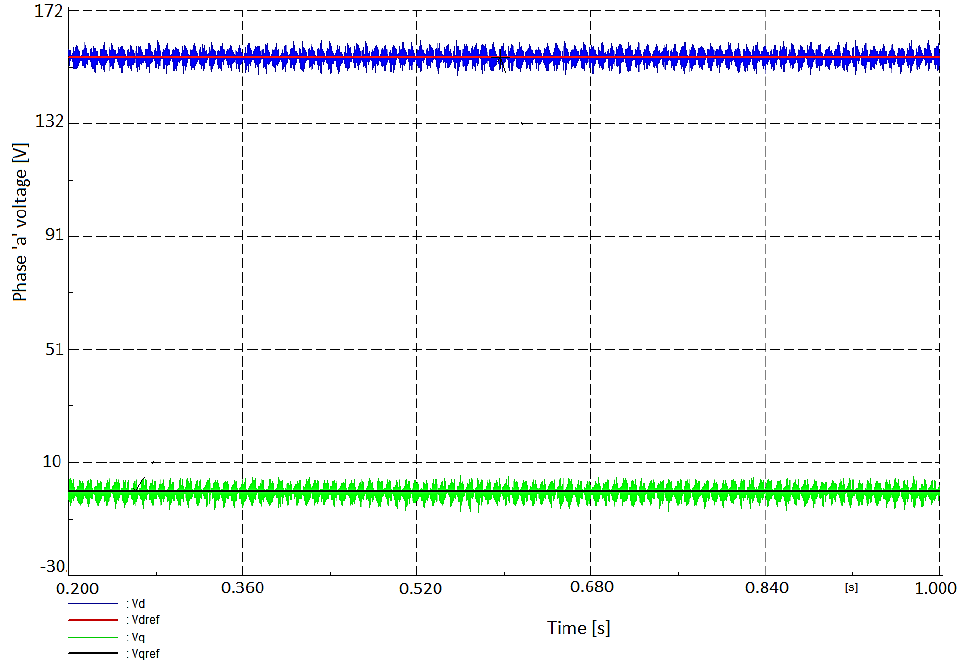
Figure 11. Reference and actual voltages of the four-leg grid-forming unit in phase ‘ a ’ in the rotating frame with the proposed control strategy.